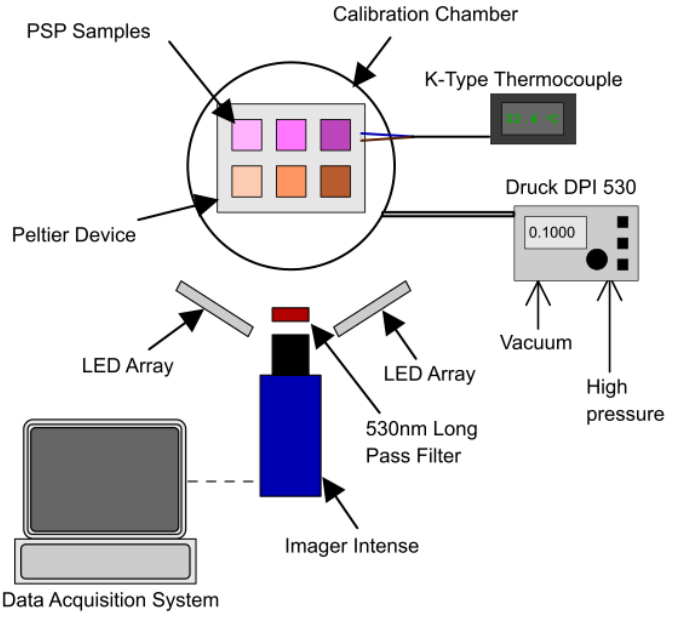
Figure 4. Schematic of the experimental